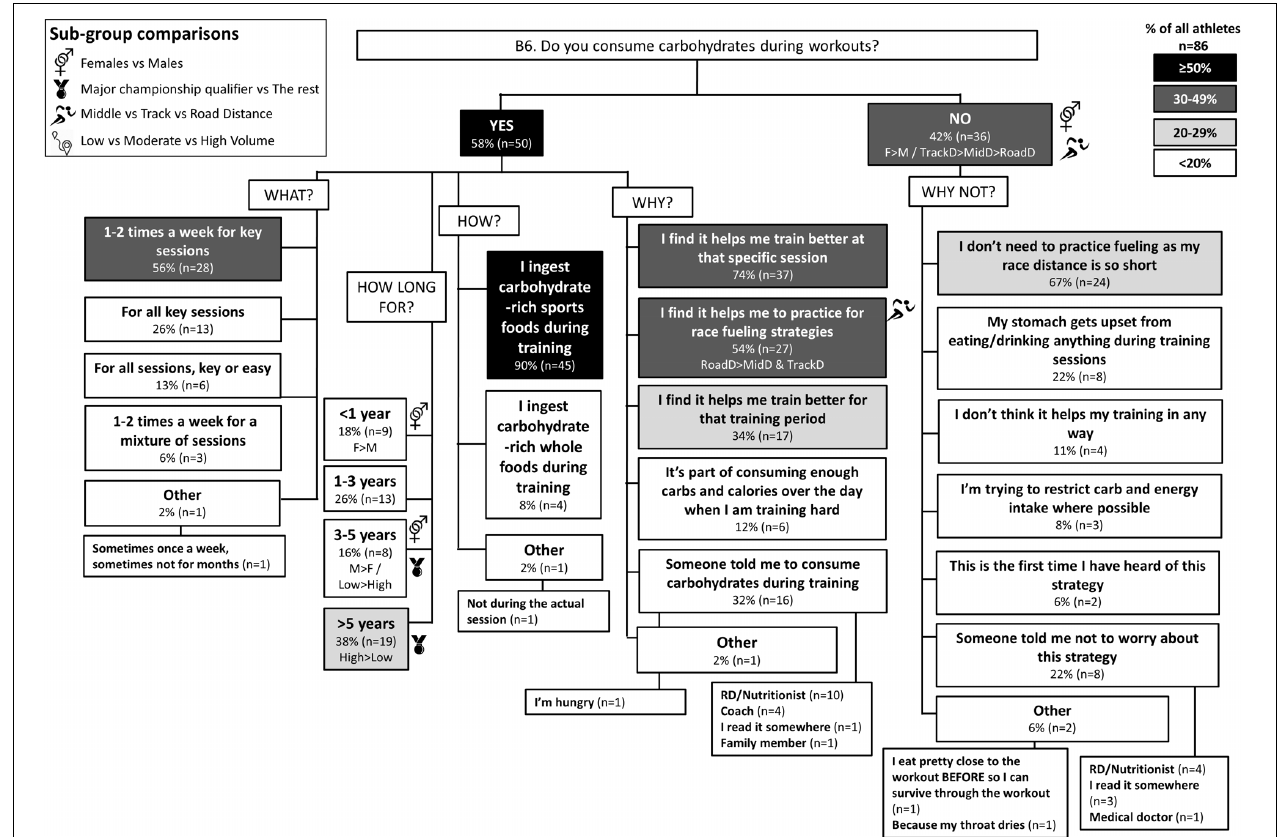
FIGURE 7 | B6: Gut training during base training phase. The prevalence of training the gut (i.e., ingesting carbohydrates during workouts) with specific details around timing, frequency and reasons for this strategy in 86 elite female and male track and field endurance athletes. Please see full description for figure within Figure 1 .